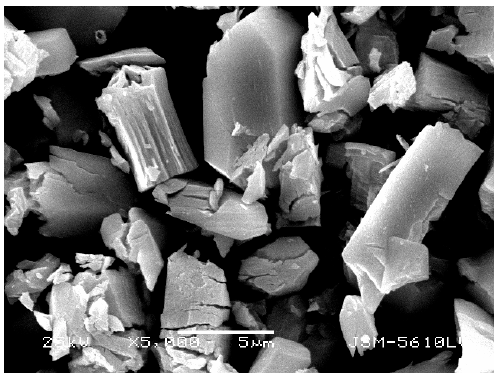
Figure 11. SEM image of the RE precursor.